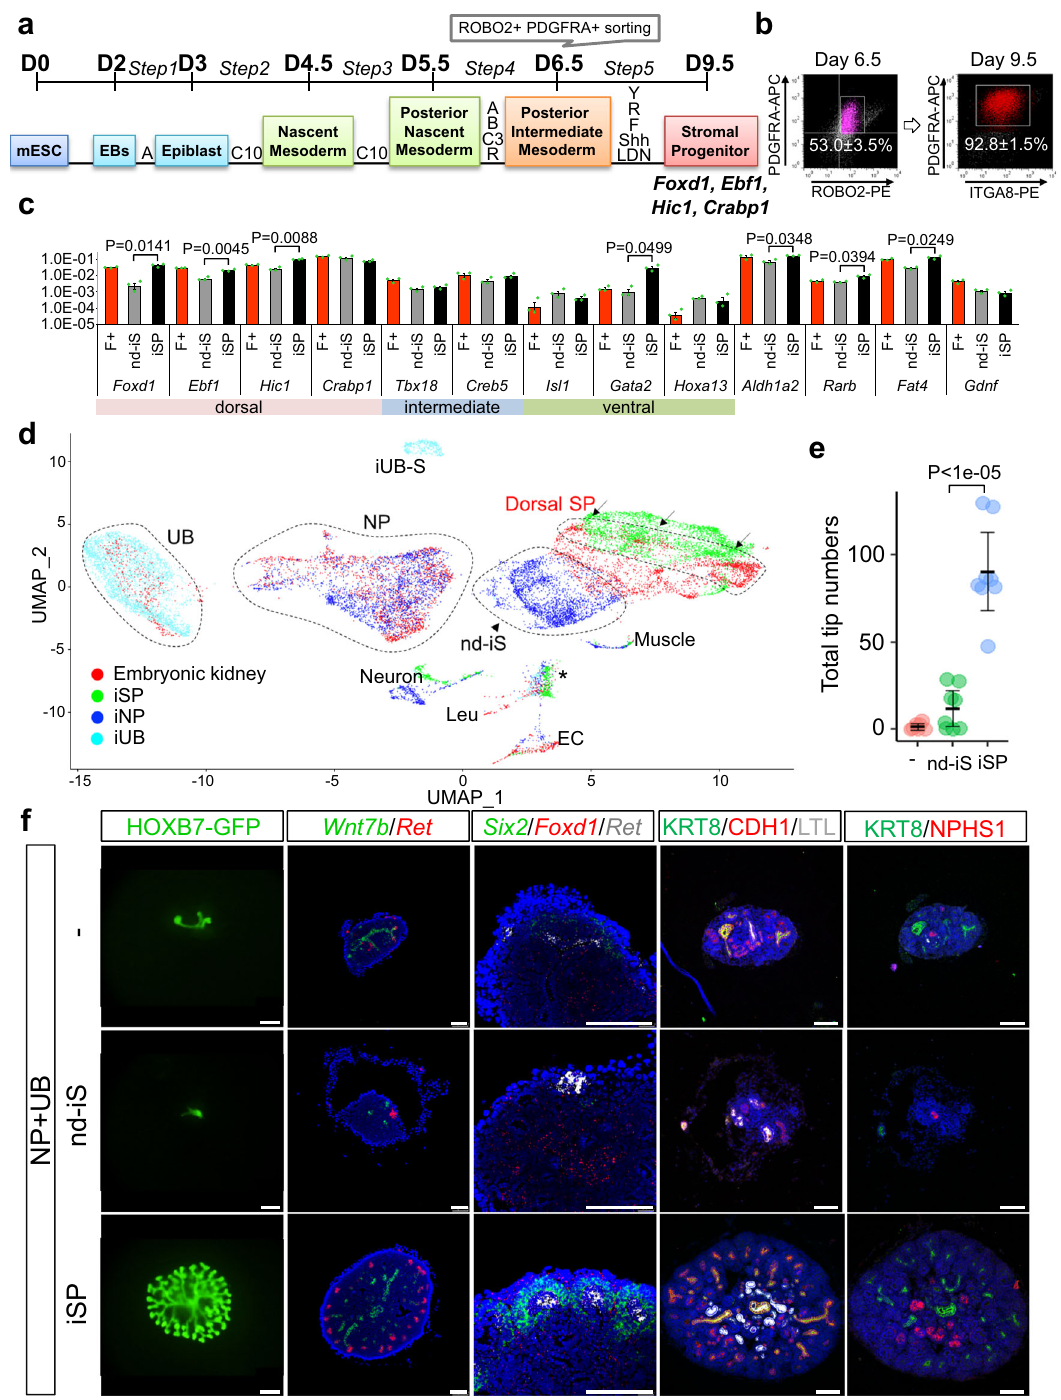
Fig. 3 Mouse ESC-derived SPs support the generation of the complex kidney structure. a SP induction protocol from mouse ESCs. A: ActivinA (10ng/ml); B: BMP4 (3ng/ml); C10: CHIR (10 µ M); C3: CHIR (3 µ M); R: RA (0.1 μ M); F: FGF9 (10ng/ml). b Flow cytometric analysis of the induced cells at day 6.5 and 9.5. c Comparison of expression levels of stromal domain-related genes between nd-iS and iSPs. F + : Foxd1-GFP + PDGFRA + dorsal SPs harvested at E11.5 (non- cultured; presented as a reference). Data are shown as mean±SEM ( n = 3 biologically independent experiments). Two-sided Student ’ s t -test was performed. The source data are provided as a Source Data fi le. d scRNA-seq analysis of mouse ESC-derived progenitors (iSPs, iNPs, iUBs) and E13.5 embryonic kidney. UMAP plots are shown. Arrows: dorsal SPs of the embryonic kidney. Arrowhead: nd-iS co-induced with iNP. EC: endothelial cells; Leu: leucocytes; iUB-S: stroma co- induced with iUB; *: dying cells. e UB branch numbers in the aggregates. Data are shown as mean±SEM ( n = 7, 7, and 8 biologically independent samples, respectively). The Tukey – Kramer test (two-sided) was performed. The source data are provided as a Source Data fi le. f Aggregates formed without stromal cells ( − ), with nd-iS, or with iSPs. NPs and UBs are isolated from the E11.5 embryonic kidneys. 1st column: GFP images of UBs; 2nd column: in situ hybridization of Wnt7 (UB stalks) and Ret (UB tips); 3rd column: in situ hybridization of Six2 (NPs), Foxd1 (SPs), and Ret (UB tips); 4th column: immunostaining of KRT8 (UBs), CDH1 (UBs, distal tubules), and LTL (proximal tubules); 5th column: immunostaining of KRT8 (UBs) and NPHS1 (glomerular podocytes). Scale bars: 100 μ m. Six aggregates in each condition obtained from three independent experiments were